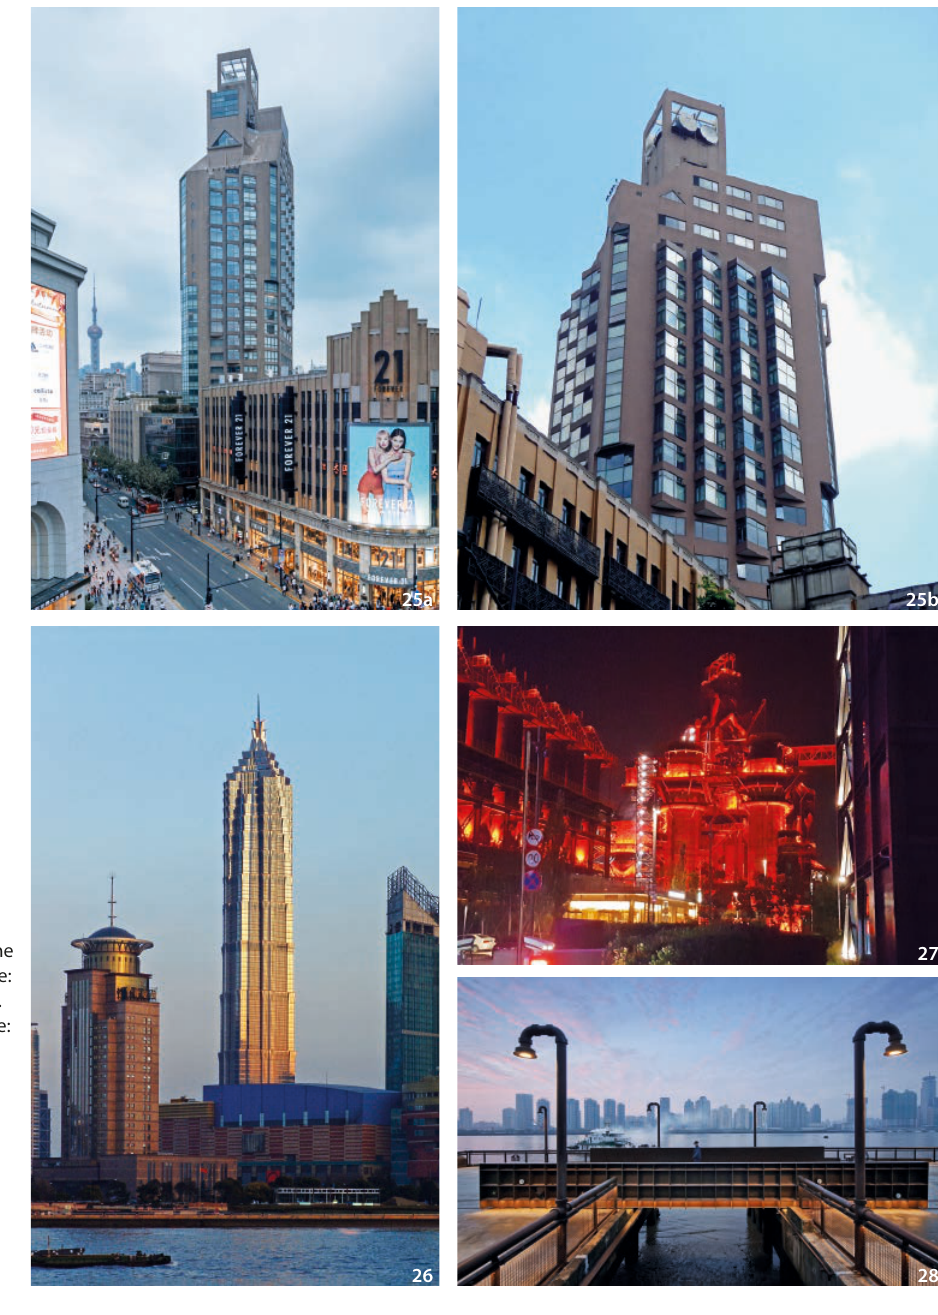
25a and 25b Shanghai Electric Power Building along the East Nanjing Road, 1988 (Source: Zhonglong Li and Qing Chang). Figure 26 Jinmao Tower (Source: Zhong Tang). Figure 27 The No. 3 furnace of Shougang Group after renova- tion, the predecessor of Shi- jingshan Iron and Steel Plant (Source: Qing Chang). Figure 28 A steel bridge at Yangshupu Gaozhuang Dock after renovation (Source: Ming